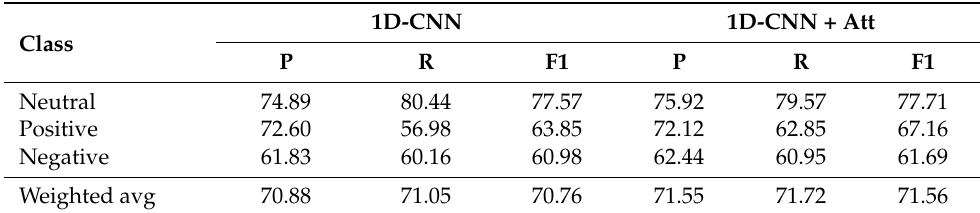
Table 5. Performance of 1D-CNN w/o